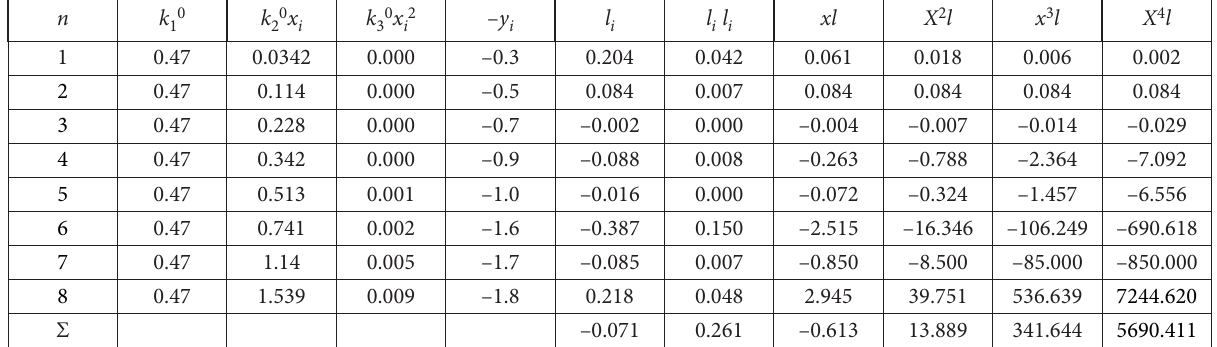
Table 6. Calculation of coefficients l i and L i (k 10 = + 0.470 ; k 20 = +0.114 ; k 30 =